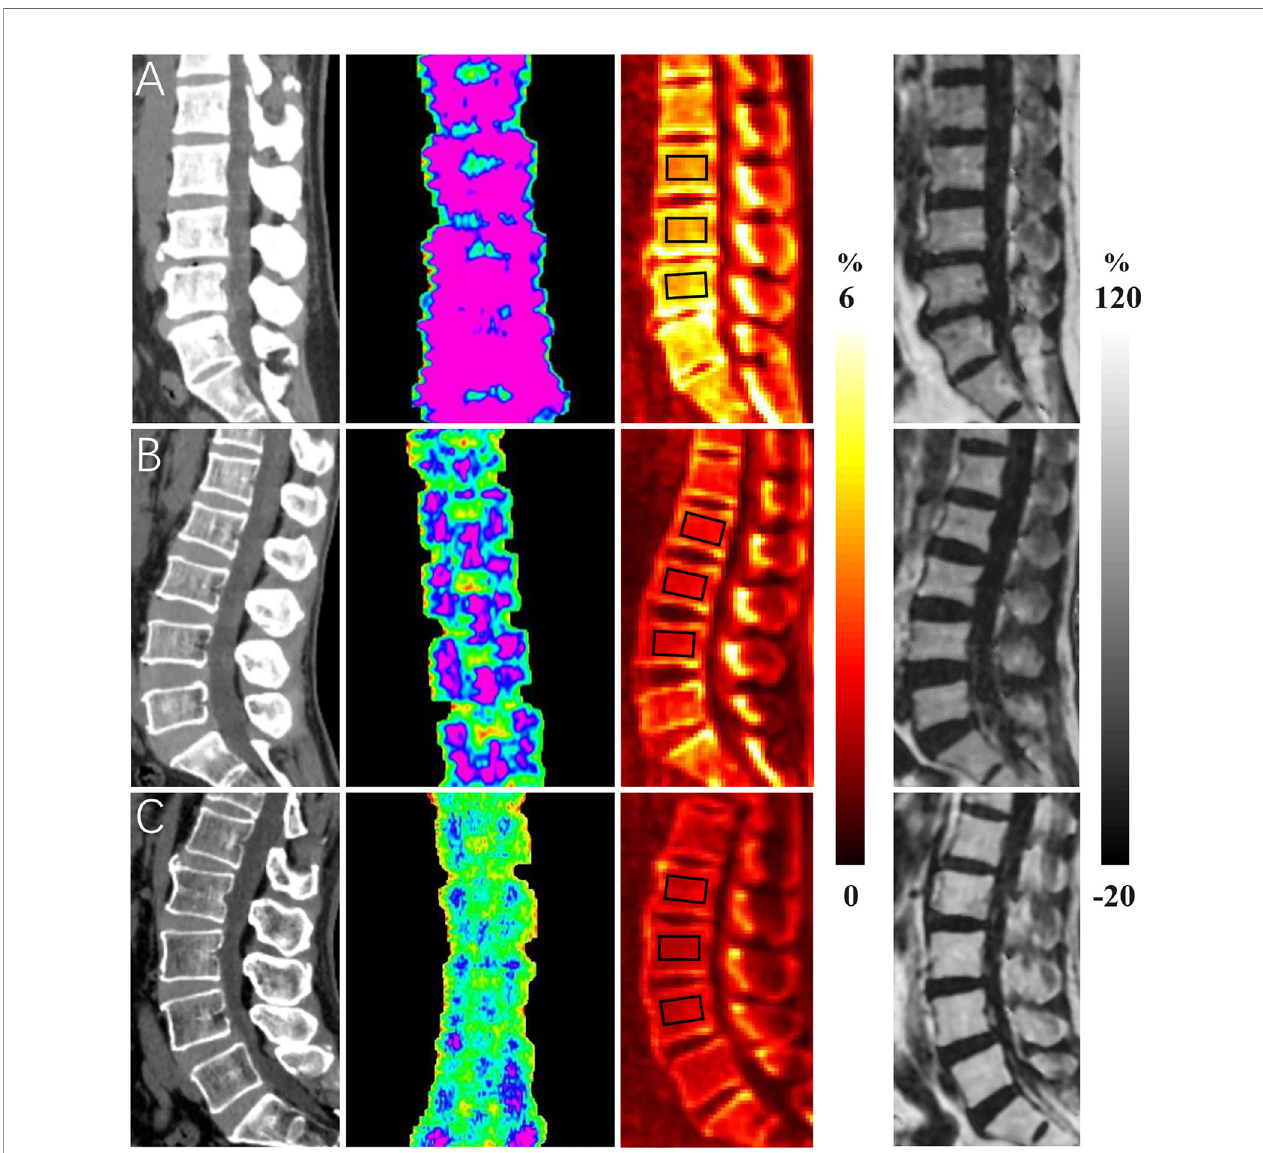
FIGURE 1 | Representative bone mineral density (BMD) ( fi rst column), T score (second column), collagen bound water proton density (CBWPD) (third column), and bone marrow fat fraction (BMFF) (fourth column) maps in the lumbar spine of three subjects with normal bone mass ( fi rst row (A) , 50-year-old male), osteopenia (second row (B) , 54-year-old female), and osteoporosis (last row (C) , 66-year-old male). ROIs inside of black squares were drawn for data